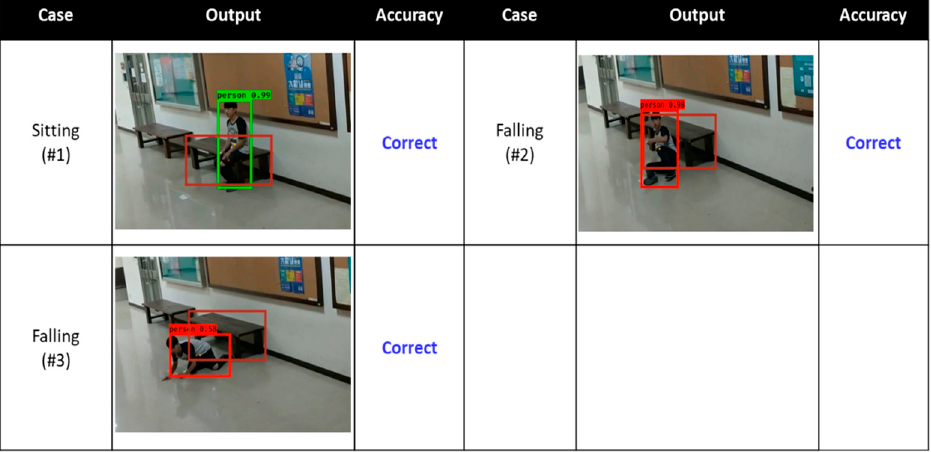
Figure 13. The results of the bench with no seatback test cases.